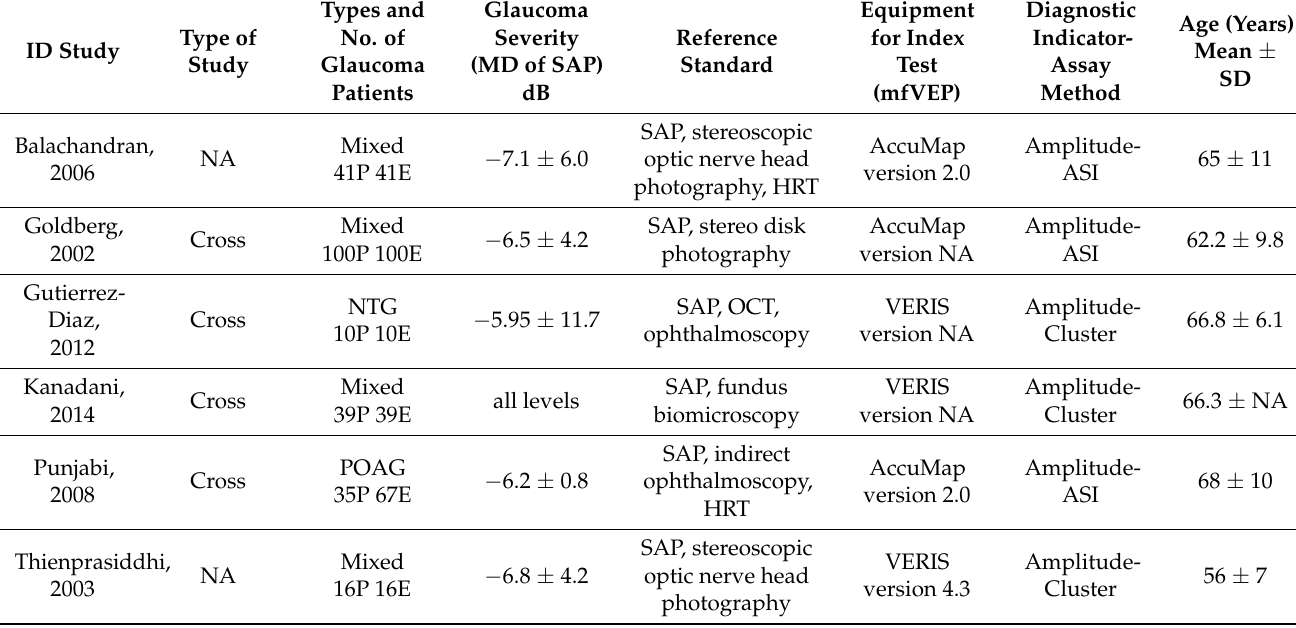
Table 1. Main characteristics of the studies included in the